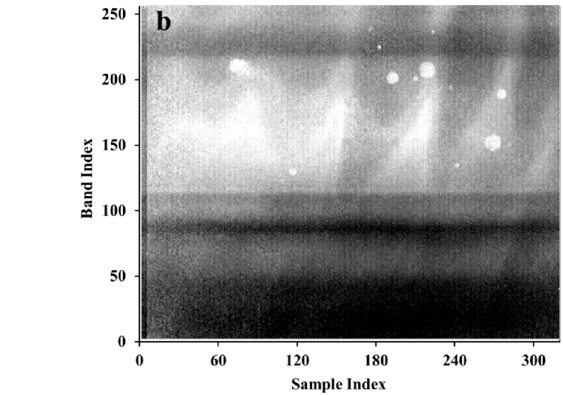
Figure 6. On-board black body data cube before ( a ) and after ( b ) blind pixel repair.